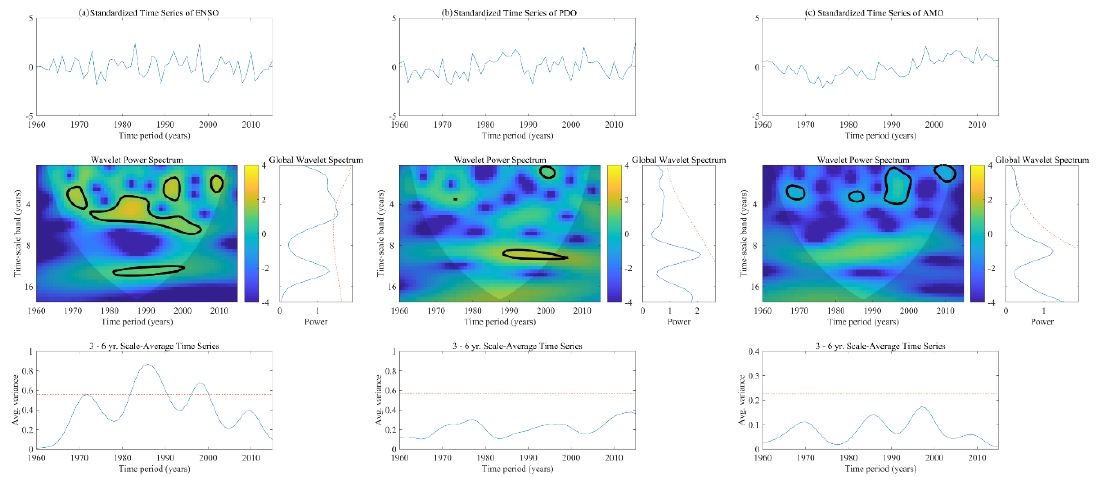
Figure 8. Continuous wavelet transforms (CWT) along with the global wavelet spectrum and the 3- to 6-year scale average time series of ( a ) ENSO, ( b ) PDO, and ( c ) AMO. Warmer (yellow) color represents higher variance in data. Zones with significant variance against 5% red noise are delineated by black contour lines.